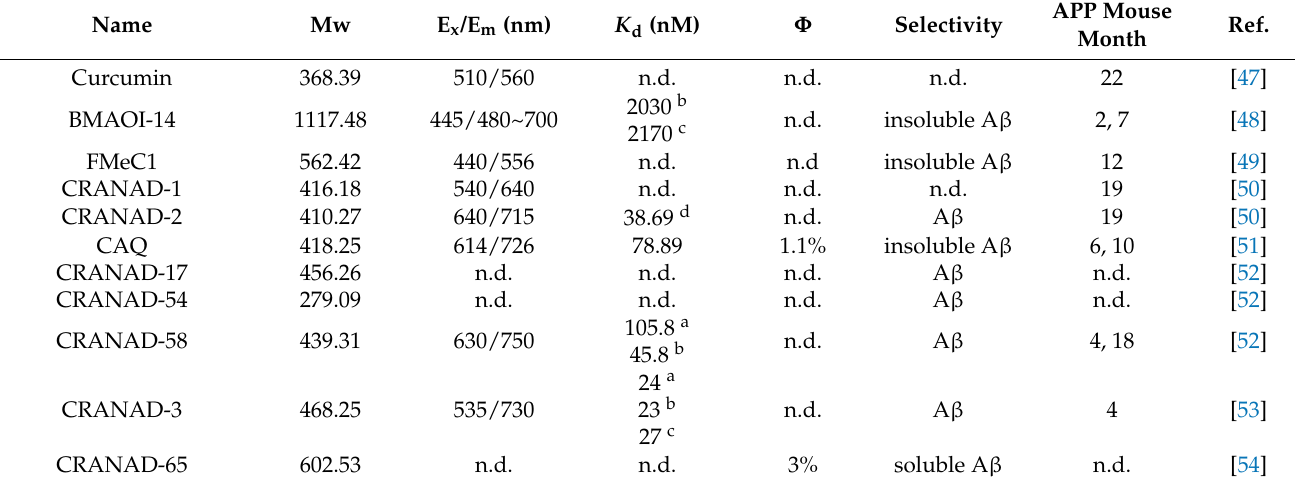
Table 1. Imaging agents designed from the curcumin scaffold for AD